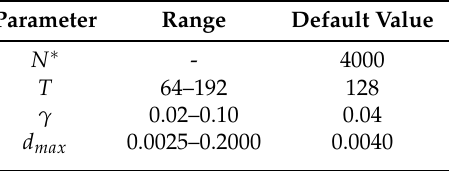
Table 3. The values of parameters.